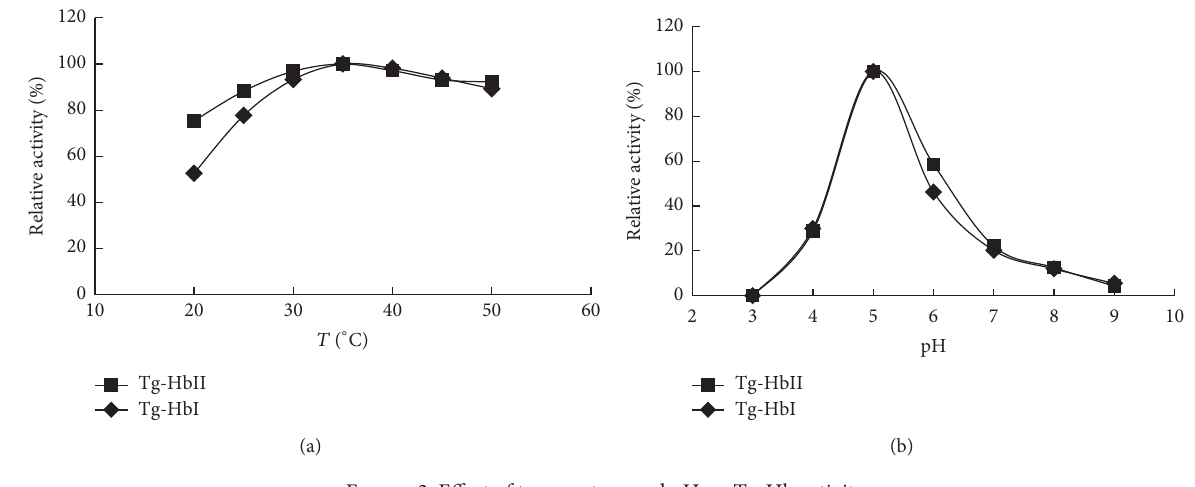
Figure 2: Effect of temperature and pH on Tg-Hb activity.